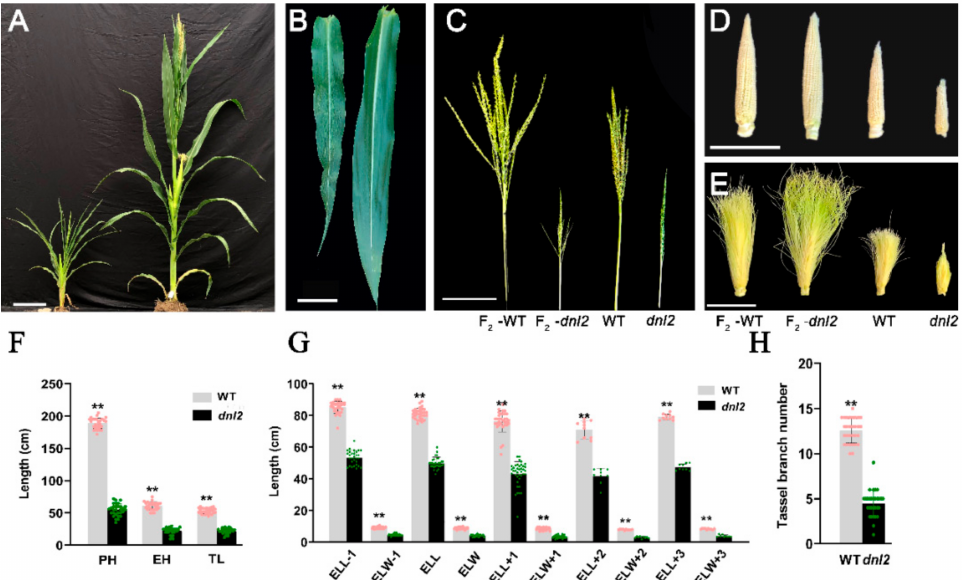
Figure 1. Gross morphology of WT and the dnl2 mutant. ( A ) dnl2 and the wild-type at tasseling stage. Bar = 20 cm. ( B ) The leaf of dnl2 and the wild-type. Bar = 10 cm. ( C ) The tassel of dnl2 and the wild-type. Bar = 5 cm. ( D , E ) The ear of dnl2 and the wild-type. Bar = 5 cm. ( F ) Plant height, ear height, and tassel length of dnl2 and the wild-type. PH: plant height. EH: ear height. TL: tassel length. ( G ) Measurement of the length and width of the first leaf below the uppermost ear, the leaf of the ear, and the three leaves above the ear. ELL-1, ELW-1: the length and width of the first leaf below the ear. ELL, ELW: the length and width of the leaf at the ear. ELL + 1, ELW + 1: length and width of the first leaf above the ear. ( H ) Tassel branch number. Data are means ± SD, asterisks indicate significant differences between dnl2 and the wild-type (** p <